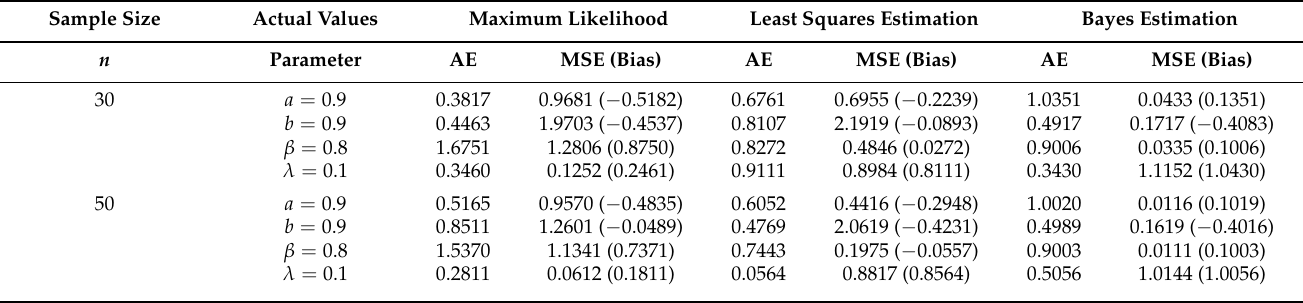
Table 5. Simulation results for the MLEs, SLEs, and BEs based on the NEKwE